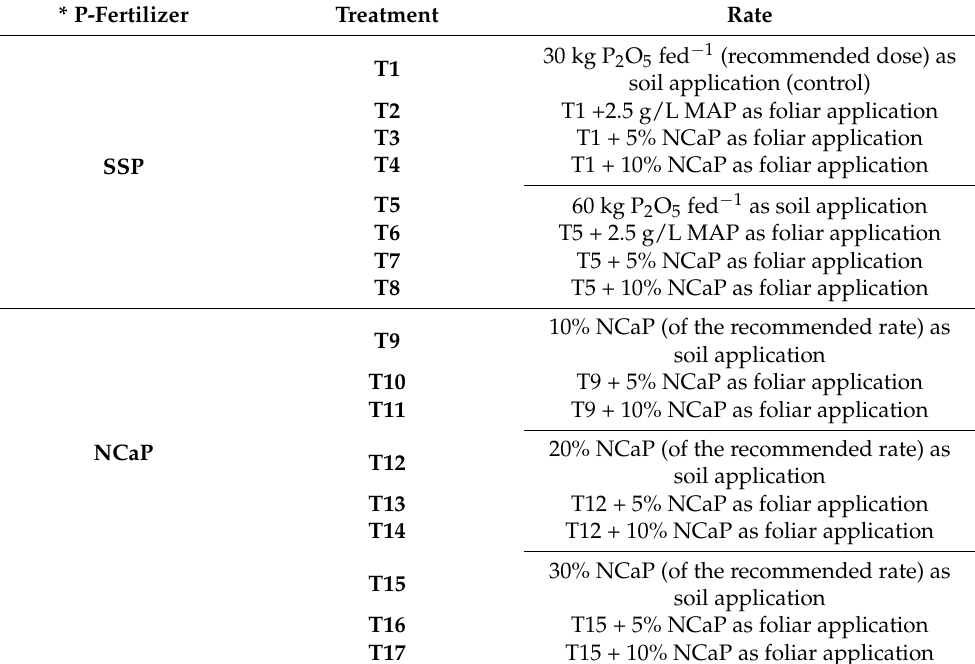
Table 2. The treatments of traditional and NCaP fertilizers tested at SI (2016–2017) and SII (2017–2018) seasons. * P-Fertilizer